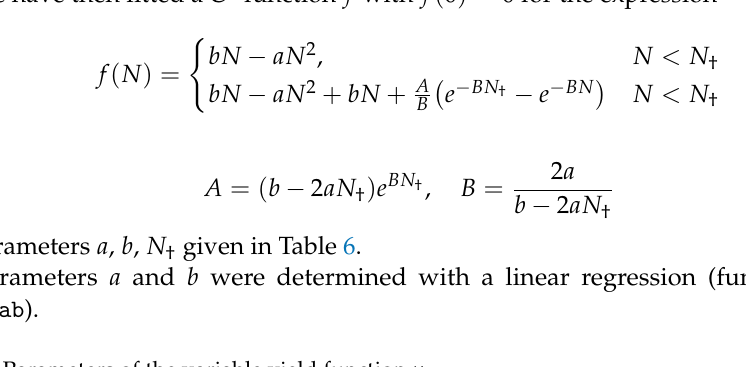
Table 6. Parameters of the variable yield function y